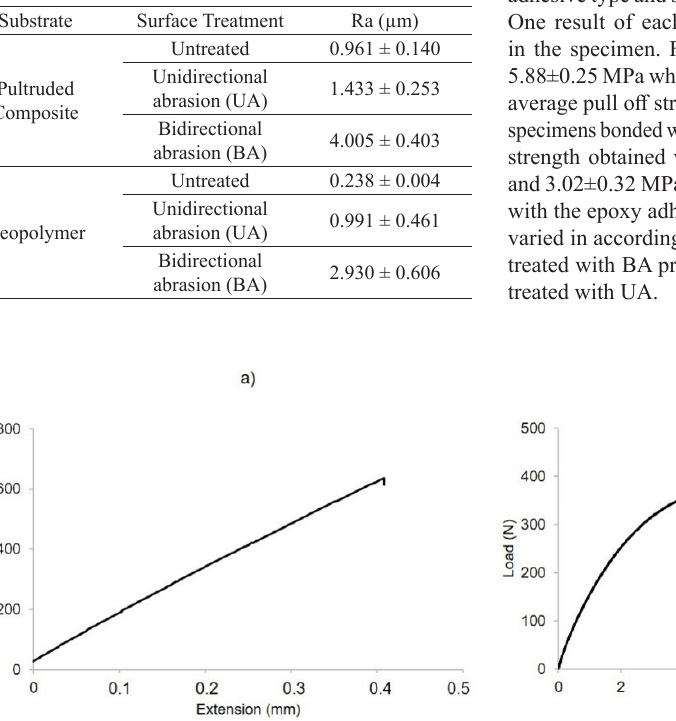
Table 3. Surface roughness of the substrates.